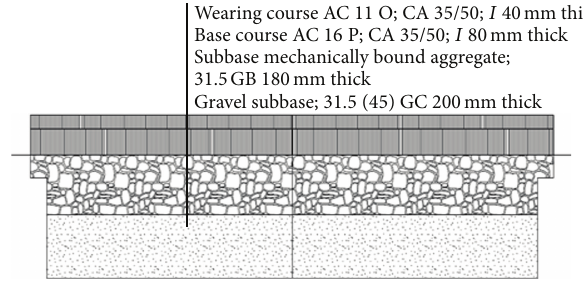
Figure 2: Pavement